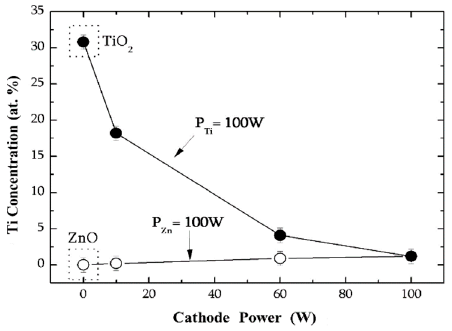
Figure 2. A variation of the Ti concentration in the films as a function of the applied power to the cathodes (Zn and Ti) for a fixed power of Ti (upper curve) and Zn (lower curve), respectively.